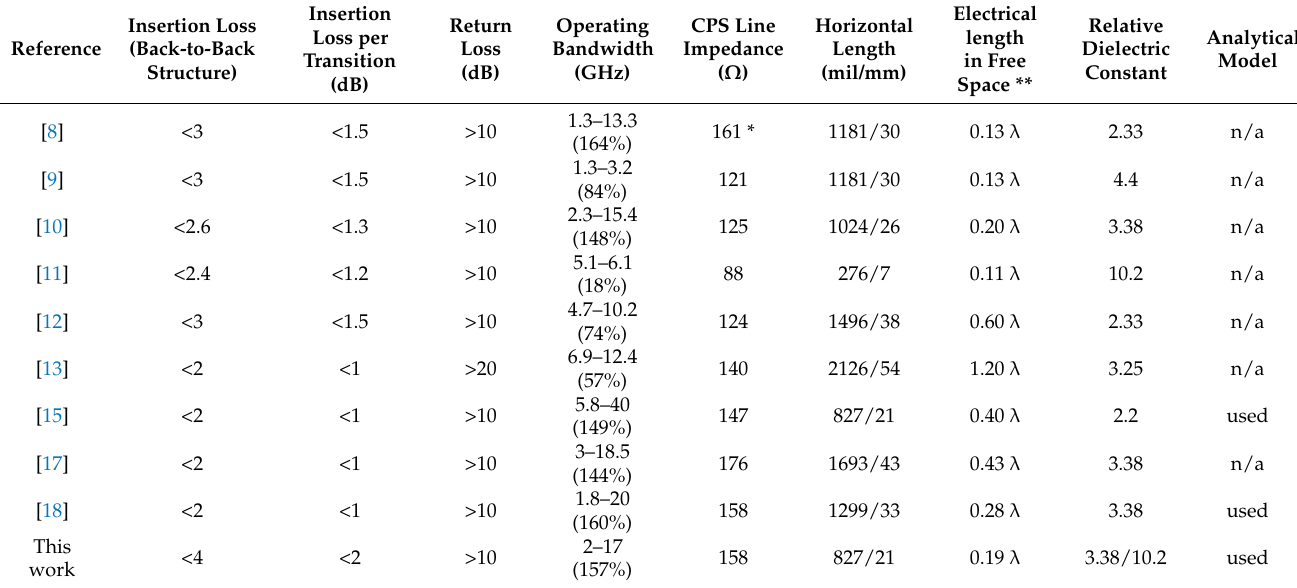
Table 2. Comparison with the reported CPS-to-MSL transitions.